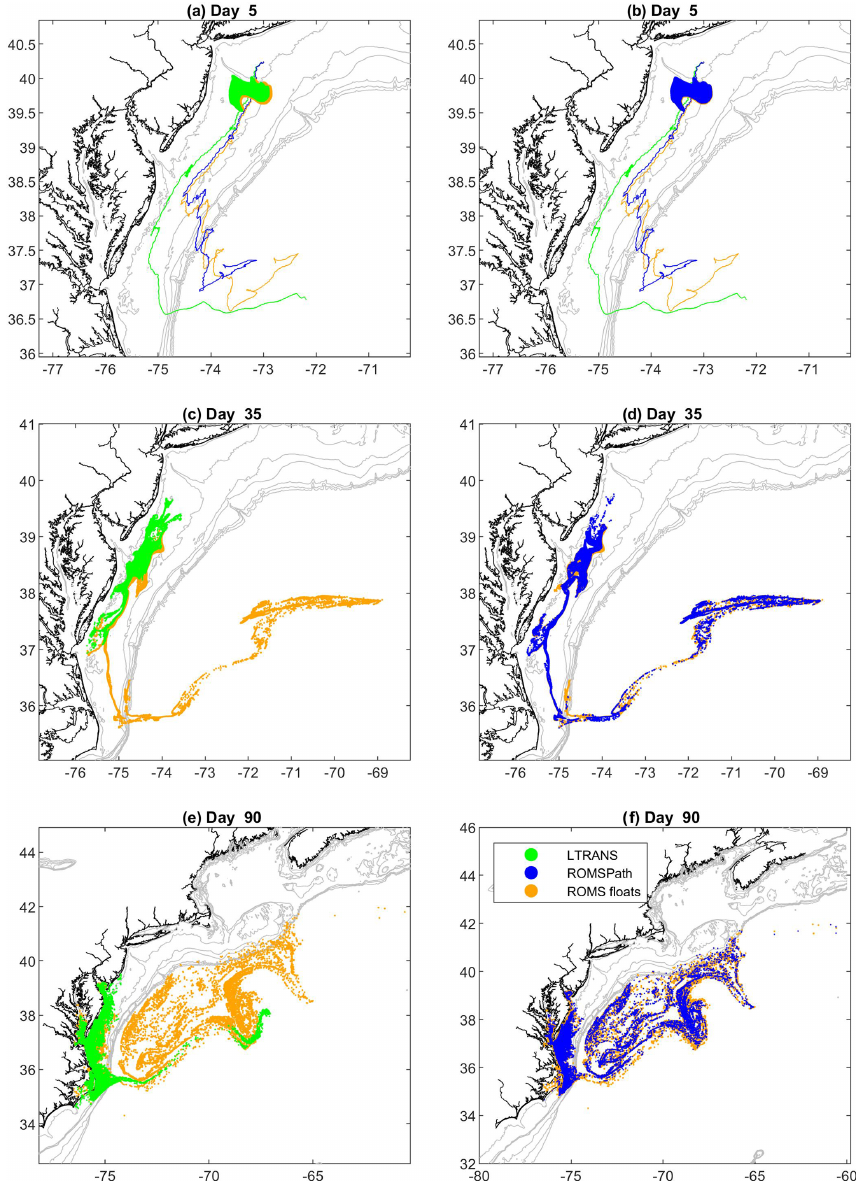
Figure 3. Comparison of particle positions from LTRANS (case A, green), ROMSPath (case B, blue) and ROMS floats (case C, yellow). ROMS floats represents the most accurate available estimates. For clarity, we show separate comparison of LTRANS versus ROMS floats (a, c, e) and ROMSPath versus ROMS floats (b, d, f) . Dots are particle positions at day 5 (a–b) , 35 (c–d) , and 90 (e–f) , and solid lines in (a) and (b) are the centers of mass of particle trajectories over the 90d simulation. The ROMSPath simulations are more consistent with ROMS floats simulations in dispersion, offshore transport, and trajectory of the center of